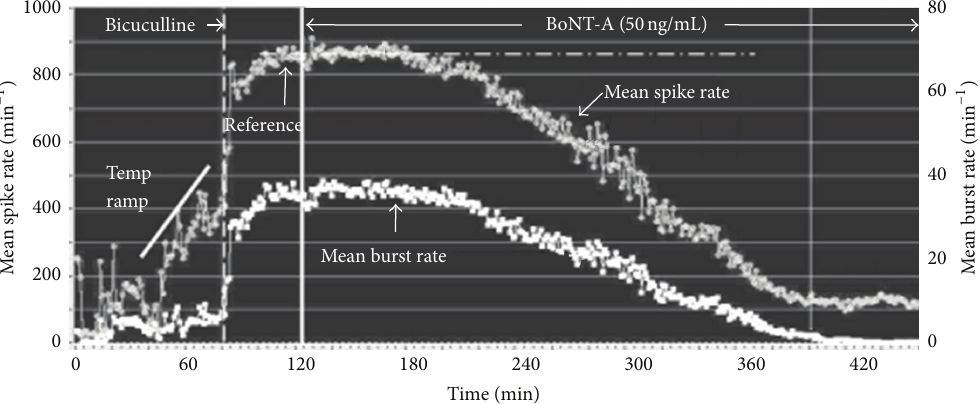
Figure 3: Temporal evolution of spike and burst rates per minute under the influence of 50 ng/mL BoNT-A. Each data point represents a one-minute average of spike rate (top trace, left ordinate) and burst rate (lower trace, right ordinate). 40 𝜇 M bicuculline was added at 83 min to increase activity and reduce minute-to-minute activity fluctuations. A stable reference state was established at 860 spikes/min and all decreases were expressed as percent of this reference state. BoNT-A was added at 124min and resulted in an irreversible decay of activity starting after a delay of approximately 80 min. Bursting ceased at 400 min with only low levels of residual spiking